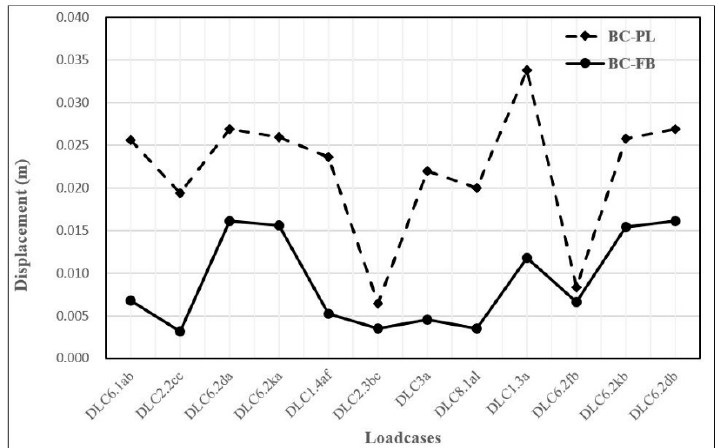
Figure 6. Comparison of displacements of BC-PL model and BC-PB model.